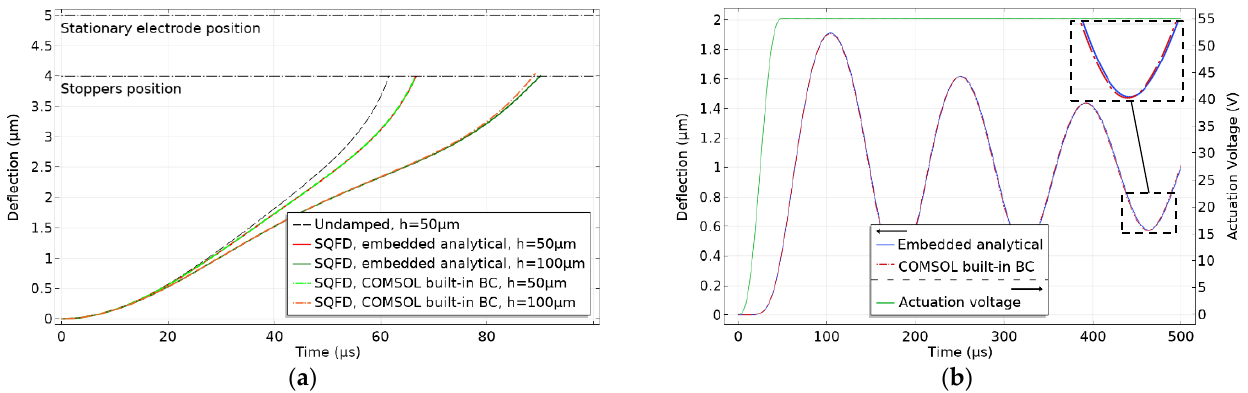
Figure 12. Comparison of the FEM simulations for the SQFD effect on a 3D model of the AUC in COMSOL. The SQFD applied via the COMSOL built-in BC is shown in contrast to the embedded analytical solution presented in this paper, which is implemented as a boundary load. ( a ) The damped deflection responses to an applied step voltage with V 0 = 61.5 V and a transition time of 1 ns for two structures with different heights, h = 50 µm and 100 µm, along with the undamped response (essentially independent of h ). ( b ) The damped deflection responses to an applied step voltage of V 0 = 55 V and a transition time of 50 µs for a cell height h = 50 µm. In these simulations, the wall thickness w w = 20 µm, whereas the other dimensions of the AUC are as listed in Table 1. Here, the pull-in voltage is ≈61 V.